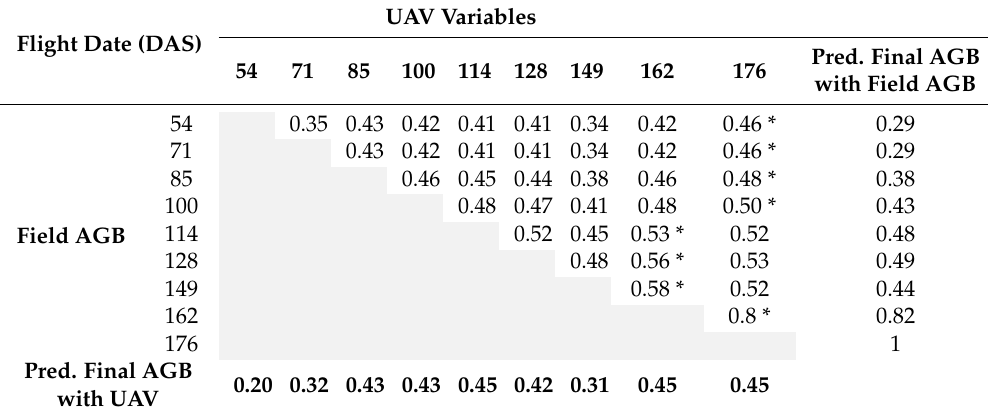
Table 3. Modeling the final AGB with the combination of UAV variables (vegetation indices and height) provided by a single flight survey with an intermediate field AGB measurement. Each cell represents the R-square (sum of the two pls components) associated with the final AGB model adjusted with the considered combination. The last row (bolded values) represents the R-square (sum of the two pls components) of final AGB models build with single date UAV products. The last column represents the R-square (sum of the two pls components) of final AGB models build with single date intermediate field AGB values. For every flight date, the best combination is marked with the *